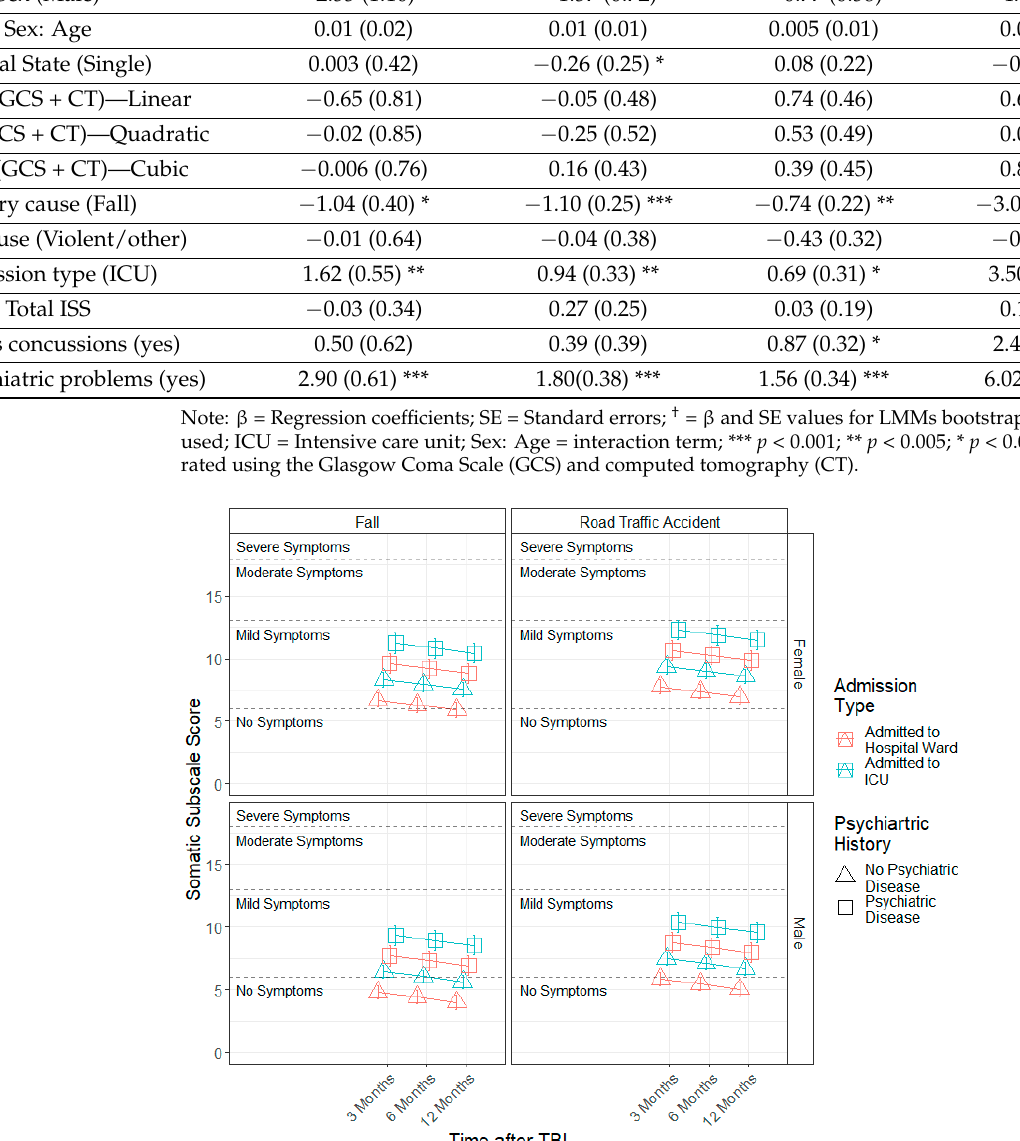
Figure 3. Modelled trajectories for the emotional factor by significant predictors.